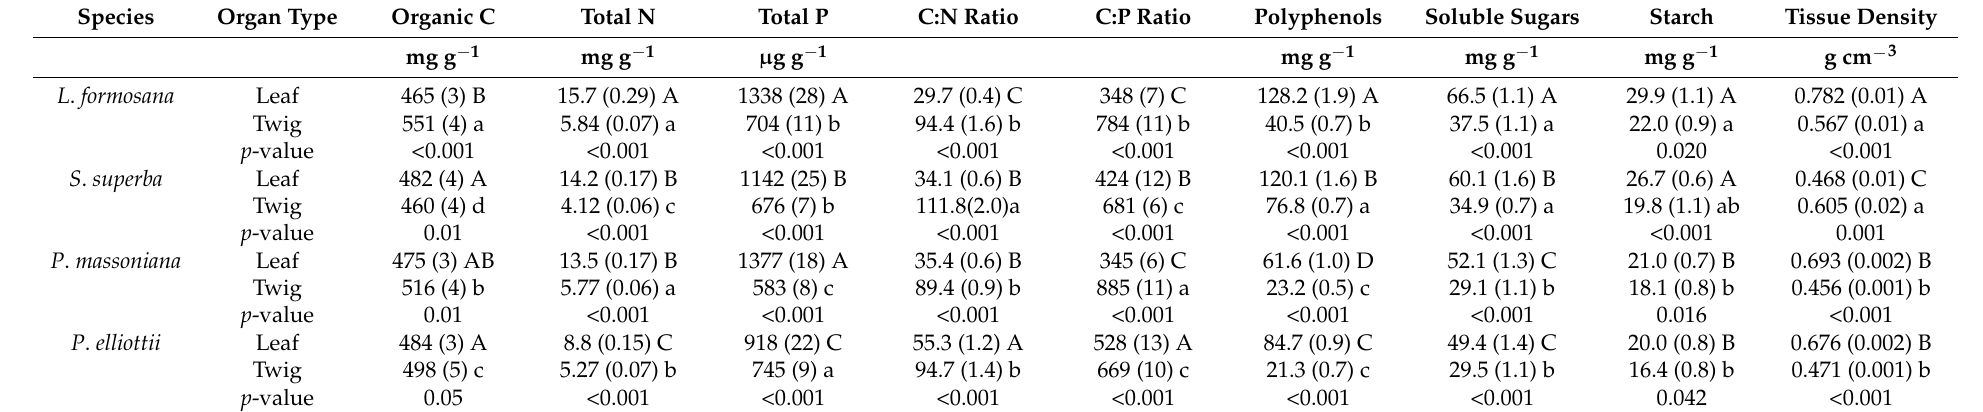
Table 1. Initial properties of tree leaf and twig in subtropical plantations in southern